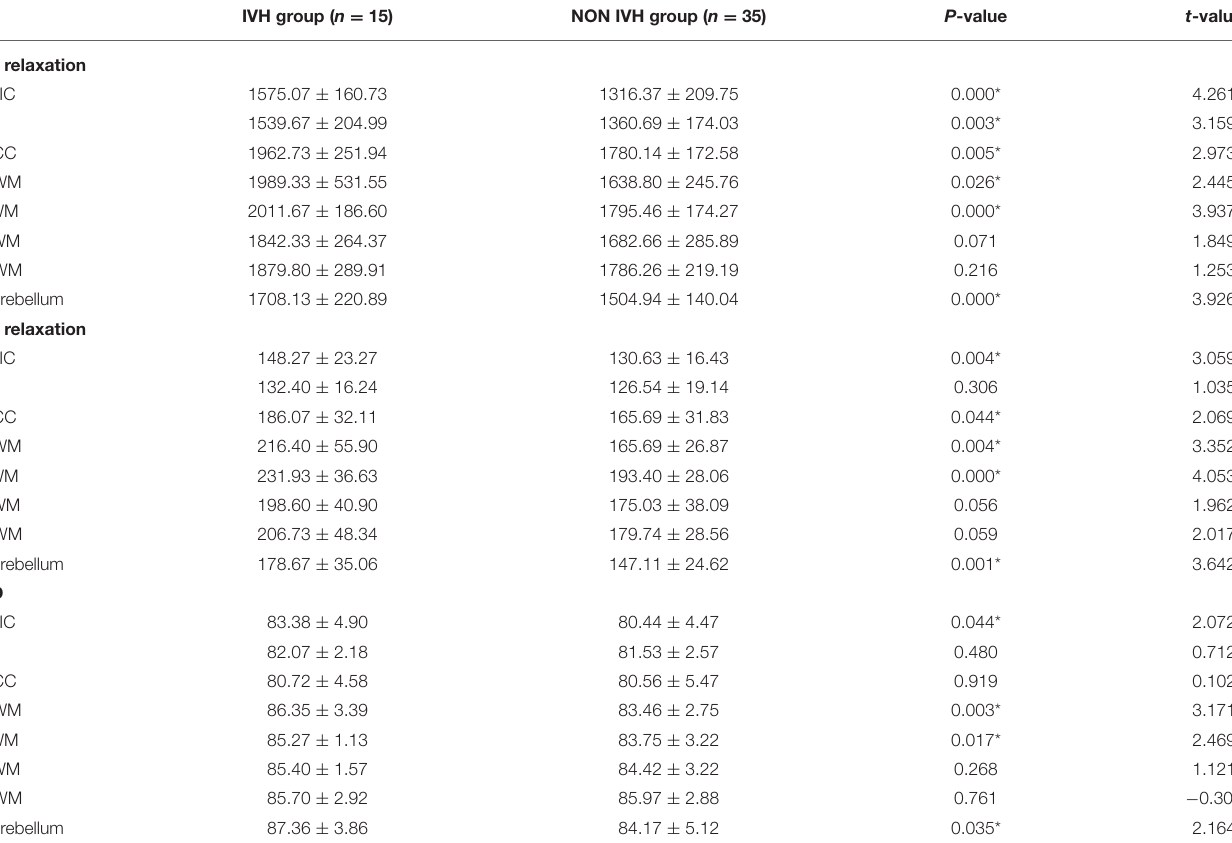
TABLE 2 | Quantitative values in IVH and NON IVH groups.